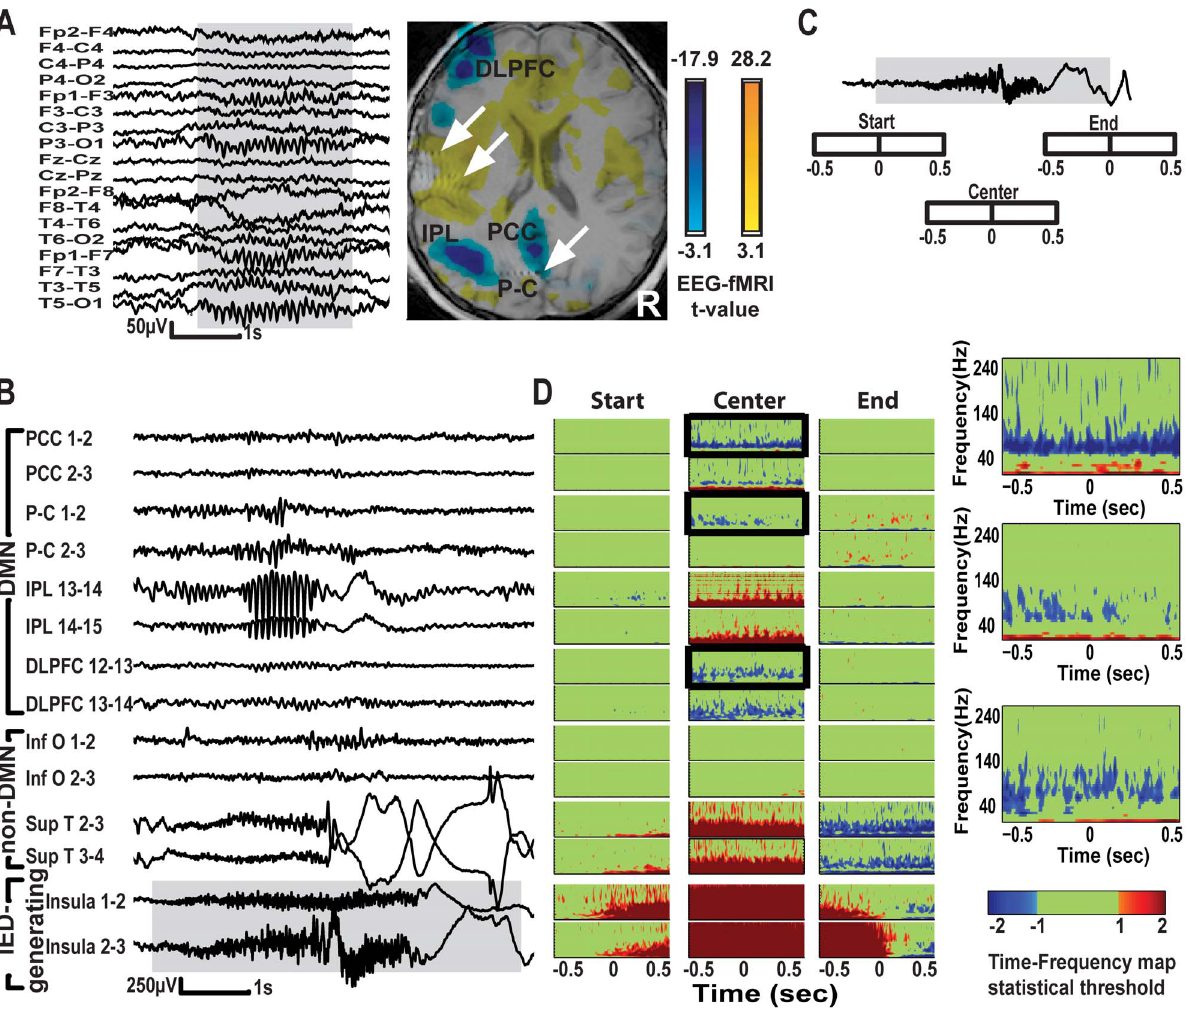
Figure 1. EEG-fMRI results and Time-Frequency (TF) statistical maps of SEEG recordings from patient 5. A – Scalp EEG showing electrographic seizure over perisylvian region and associated BOLD changes. Functional map is co-registered with anatomical MRI and CT showing the sampling of P-C, insula and temporal cortex by SEEG electrodes (marked by white arrows, other electrodes are not shown). Functional maps show activations in left insula and bilateral cingulate and deactivations in DMN nodes of left hemisphere. B - SEEG traces showing typical electrographic seizure originating from left insula (lower 2 traces) and SEEG in left PCC, P-C, IPL, DLPFC, inferior occipital and superior temporal regions. Each region was sampled with 2 consecutive bipolar channels 5 mm apart, and higher number denotes a more lateral channel. Note the spread of seizure activity to the IPL and temporal cortex and that the activity in IPL is identical to the activity measured on the scalp. C – Schematic representation of a typical electrographic seizure (not in scale) and 1 s epochs centered at the start, center, and end of the seizure. Epochs can overlap depending on the length of the IED. D – TF maps of statistically significant z values comparing start, center, and end of IED with baseline. They show decrease in gamma and increase in frequencies , 30 Hz coinciding with the center of the seizure in PCC, P-C, DLPFC, whereas IPL and superior temporal gyrus show increase of frequencies up to 60 and 120 Hz, respectively, secondary to spread of epileptic activity. Boxed TF maps are shown in higher magnification on the right. Statistical threshold obtained after false discovery rate correction (indicated as ‘‘1’’ in color bar). Plots are saturated at a z value that is double the threshold value (indicated as ‘‘2’’). Non-significant pixels (below false discovery rate threshold) are displayed in green.